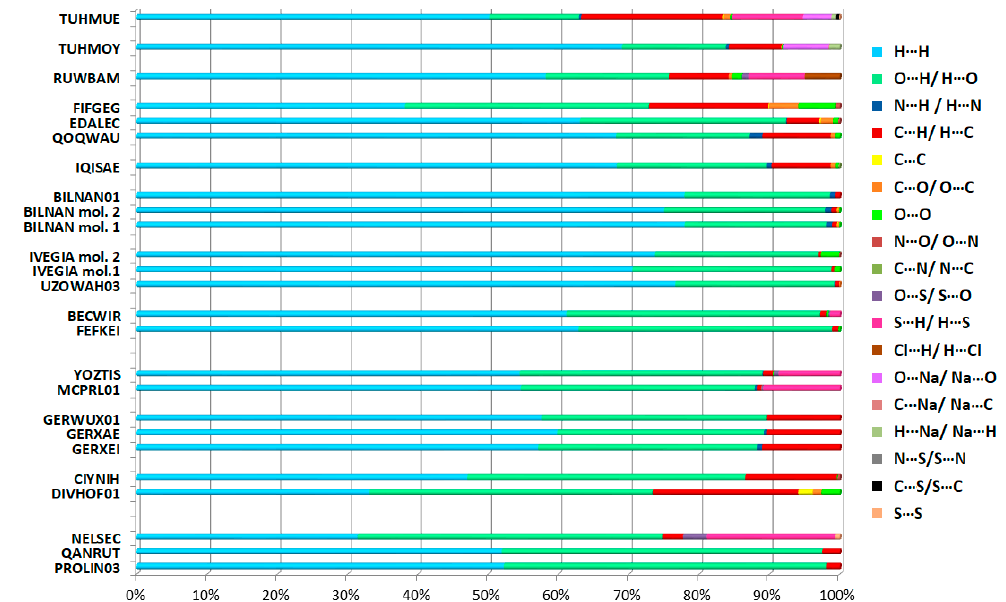
Figure 9. Relative contributions of the different interactions to the Hirshfeld surface for all analysed proline-derived structures.